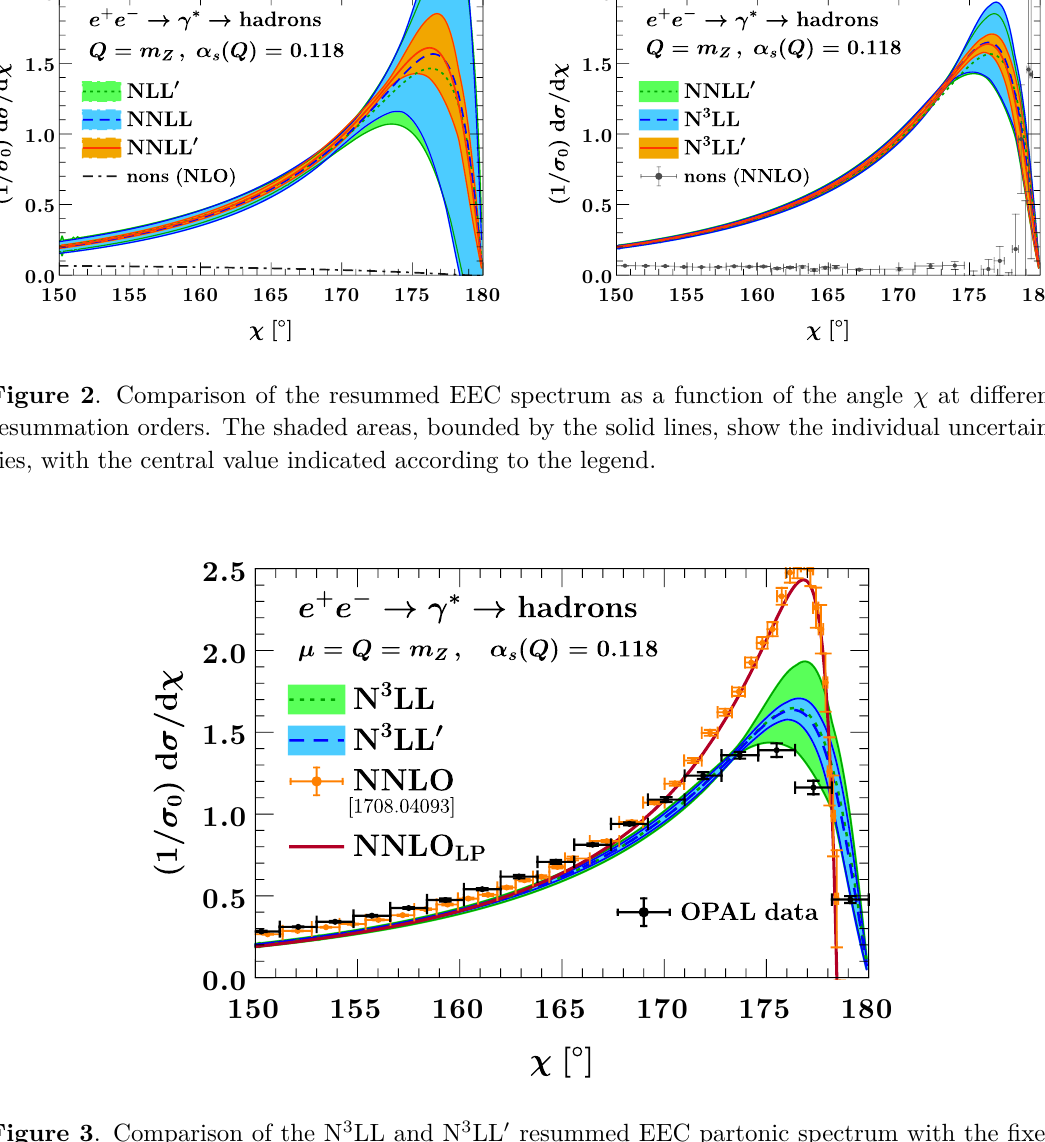
Figure 3 . Comparison of the N 3 LL and N 3 LL 0 resummed EEC partonic spectrum with the fixed order NNLO numerical calculation of ref. [7], the LEP data from the OPAL collaboration [4], and the analytic leading power spectrum at O ( α 3 ) 12 from eq. s